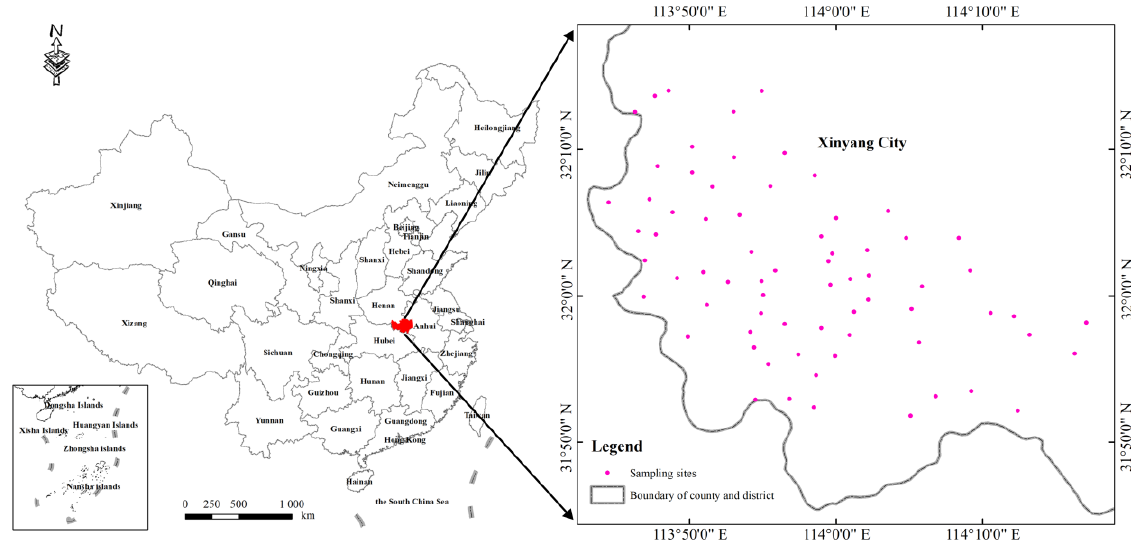
Figure 1. The study area and the distribution of sampling sites.